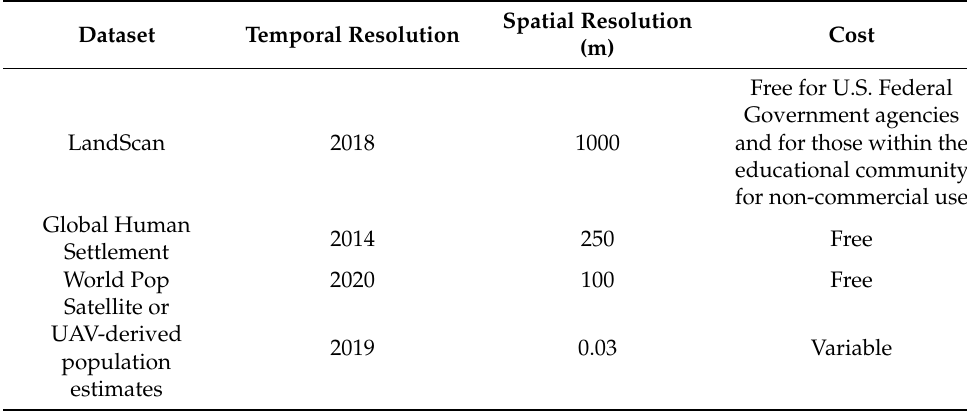
Table 2. Available Population Datasets for